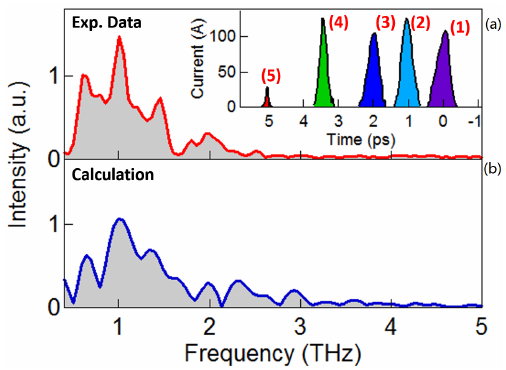
Figure 5. THz generation via Coherent Transition Radiation (CTR) by a five comb beam: ( a ) Experimental data ( b ) Numerical calculation from measured current distribution reported in the inset. Table 1. Electron beam parameters for the three different configurations of the five bunches. Comb Beam 1 Comb Beam 2 Ramp Inter-Distance (4)-(5) = 1.6 ps Inter-Distance (4)-(5) = 0.5